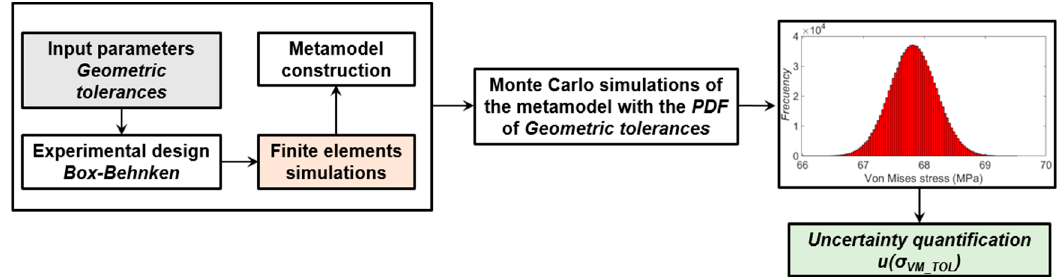
Figure 13. Uncertainty quantification procedure of the computational stress due to materials properties.